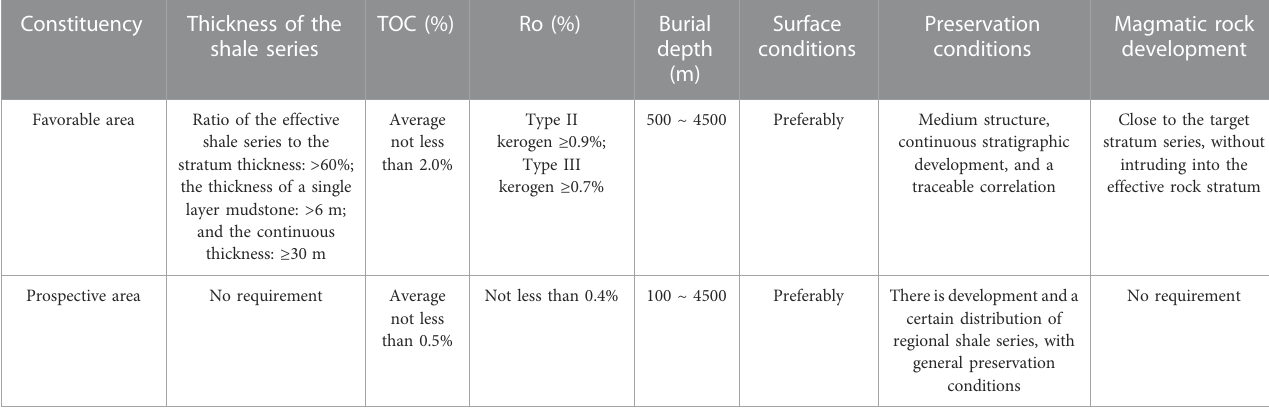
TABLE 6 Reference standard for SG area selection in the Huanghebei Coal fi